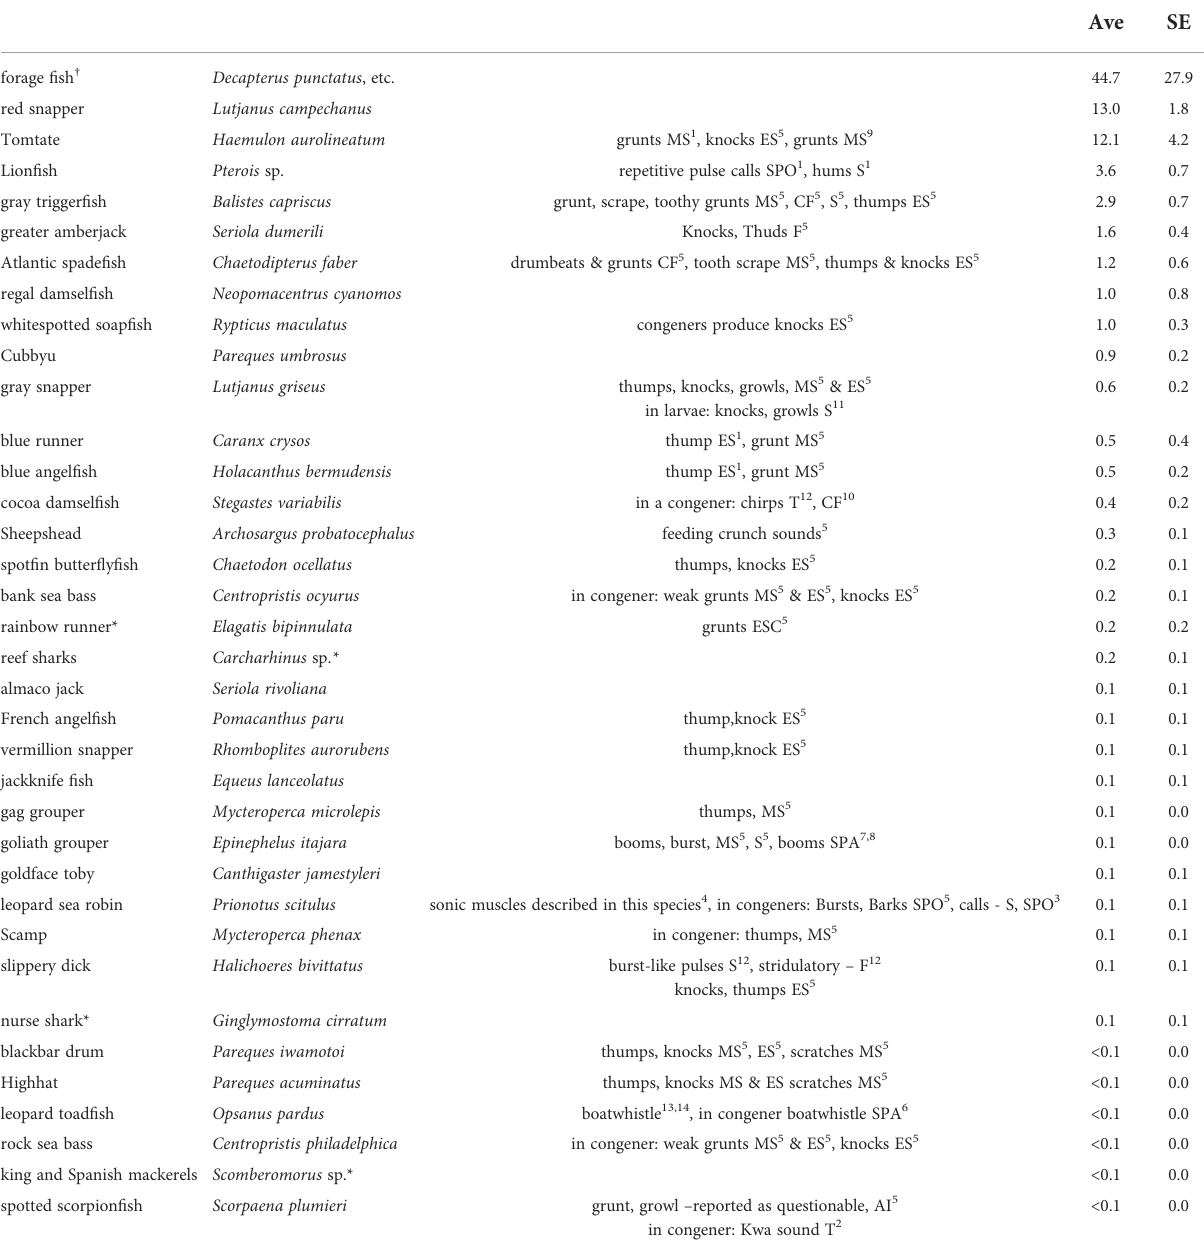
TABLE 3 Fish species estimated relative abundance (MAXNO, maximum number of fi sh observed in a single video frame) among arti fi cial reef